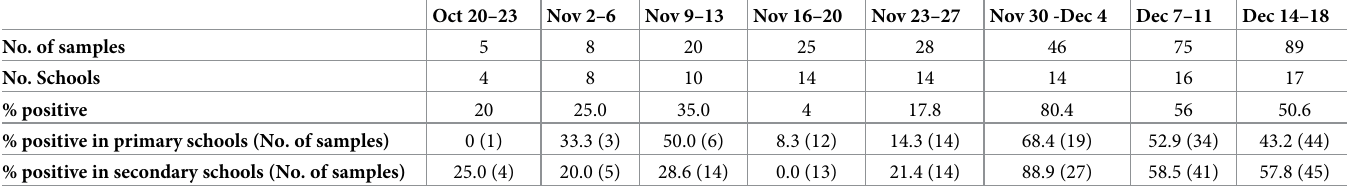
Table 3. Number of samples, percentage of positive cases (total and by stage of education) by